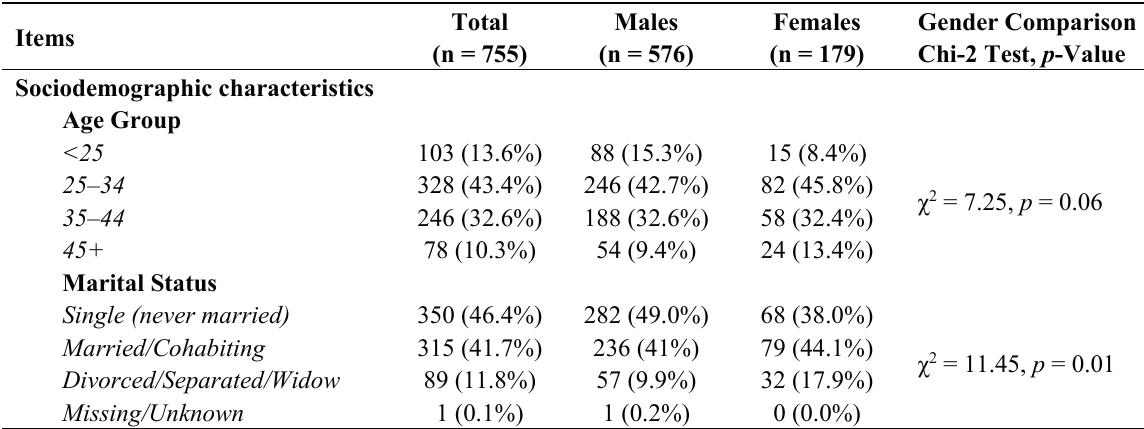
Table 1. Sociodemographics characteristics of labour camp detainees, male and